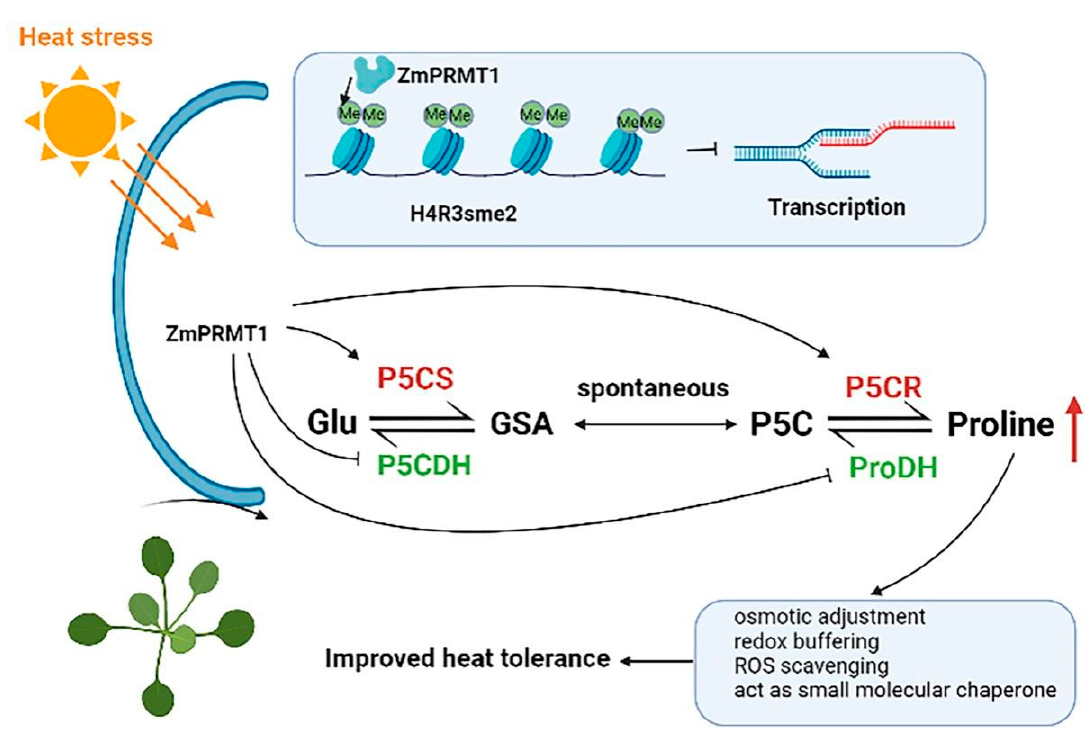
Figure 13. Hypothetical model showing the overexpression of ZmPRMT1 results in improved resistance under heat stress in Arabidopsis involving proline metabolism pathway. The pathway of proline metabolism. Glu glutamic acid, GSA glutamate-1-semi-aldehyde, P5C pyrroline-5-carboxylate, P5CS1 delta-1-pyrroline-5-carboxylate synthase1, P5CR pyrroline-5-carboxylate reductase, P5CDH delta-1-pyrroline-5-carboxylate dehydrogenase, ProDH proline dehydrogenase. Overexpression of ZmPRMT1 in Arabidopsis leads to upregulation of the expression levels of P5CS1 and P5CR gene in proline synthesis pathway while downregulation of the expression levels of P5CDH and PDH gene in the proline degradation pathway. Finally, proline accumulation increased. H4R3sme2 is one of the possible targets for ZmPRMT1 to function. The upregulation of gene expression levels is represented by red font, whereas downregulation of gene expression levels is represented by green font. The arrows indicate positive modulation, and the “T” bars indicate negative modulation. The dashed lines represent assumed interactions.